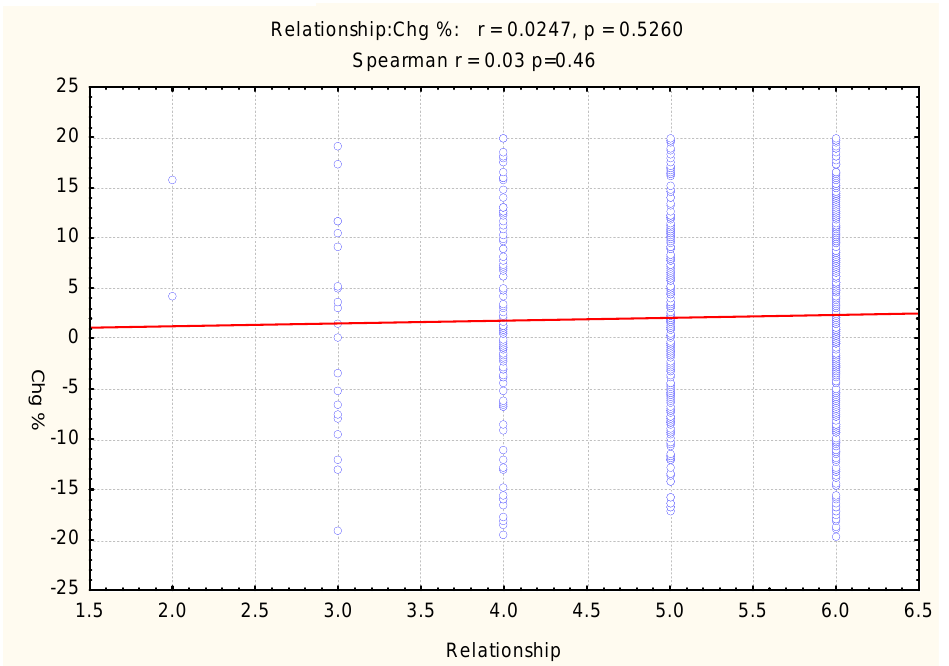
Figure 3: Scatter plot on the range of growth: -20% to